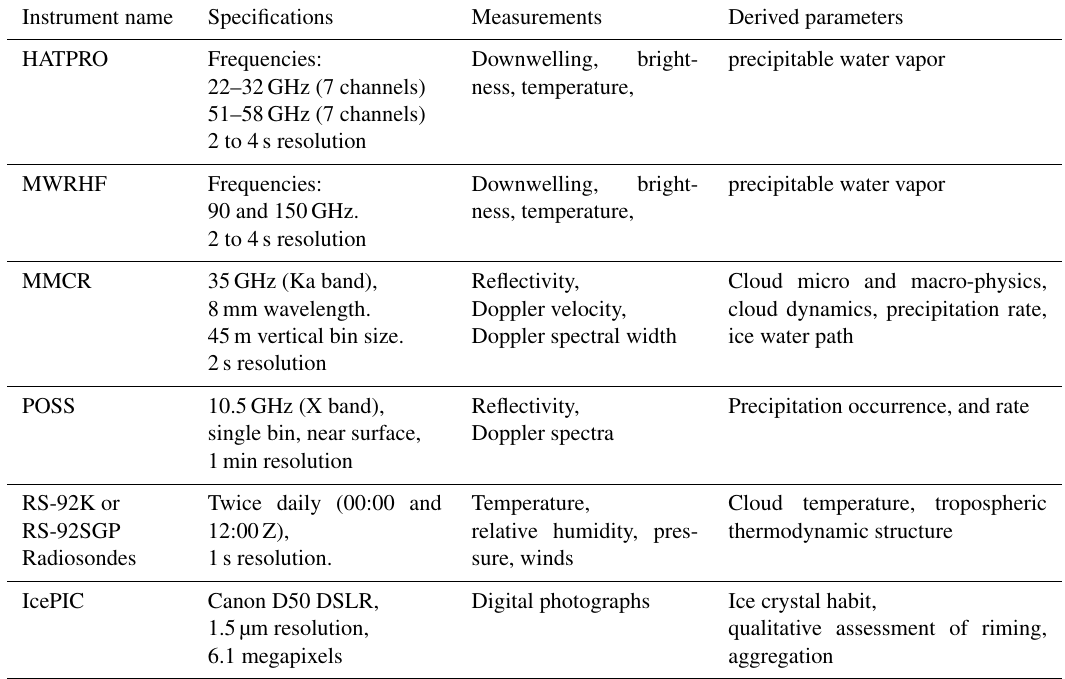
Table 1. Subset of ICECAPS instruments used for this study (modified from Table 1 in Shupe et al.,